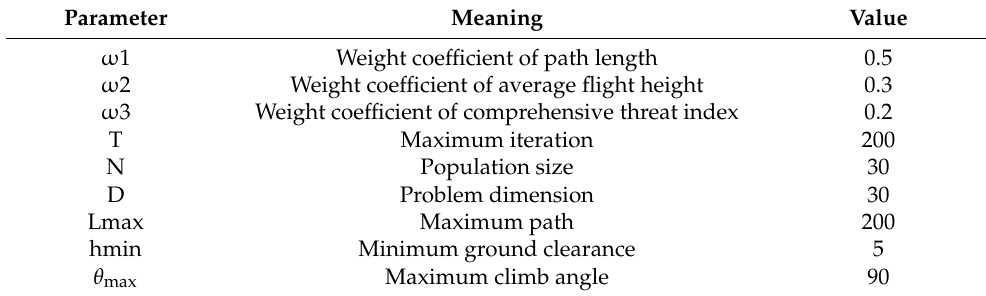
Table 1. Initial parameters of BINN-HHO.